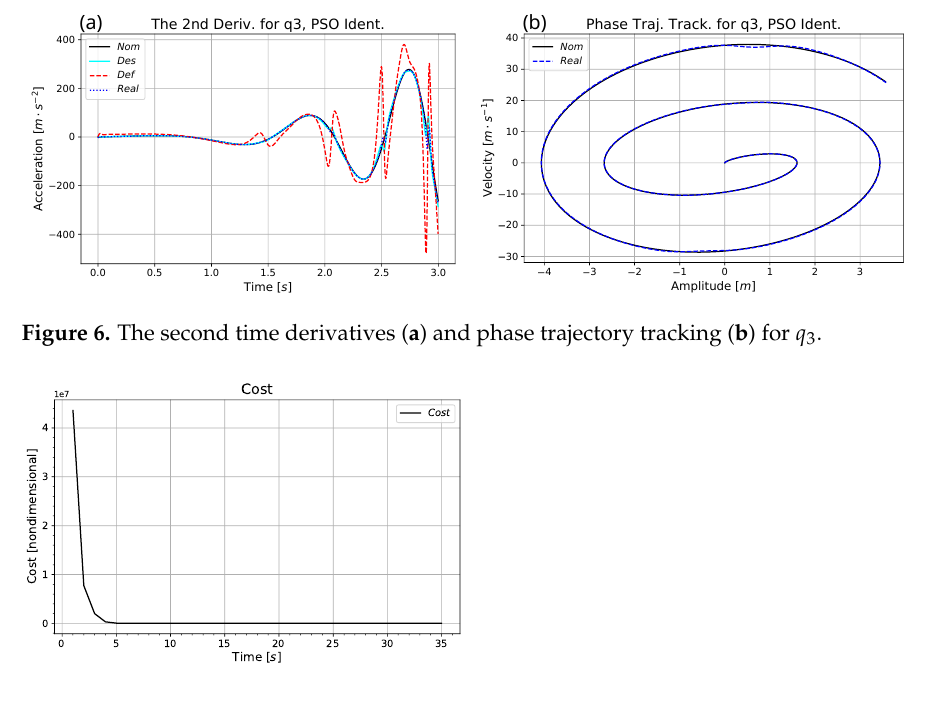
Figure 7. The cost function of the best estimation of the model during PSO teaching iteration. The accuracy of each estimated value for each targeted parameter is shown in Figure 8. For revealing the estimation accuracy in the five-dimensional parameter space, Figures 9 and 10 display the story of the “best global particle” in various 2D projections.